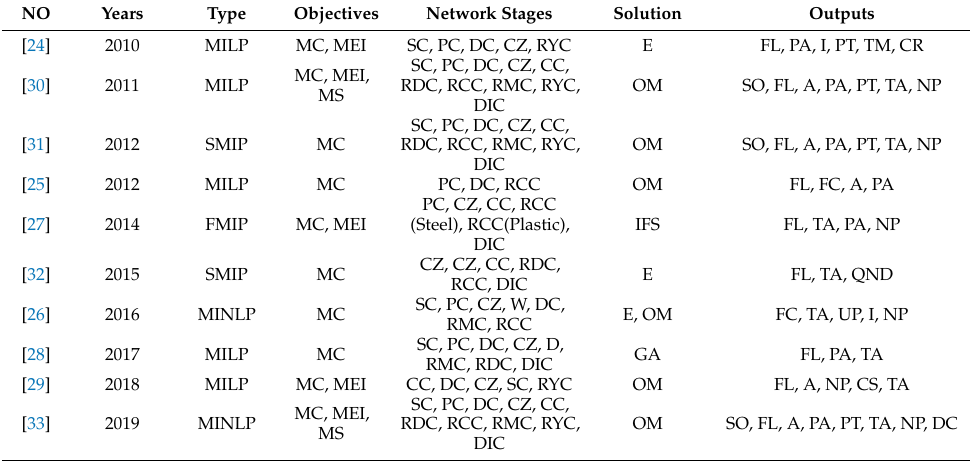
Table 3. Mathematical model of CLNS.